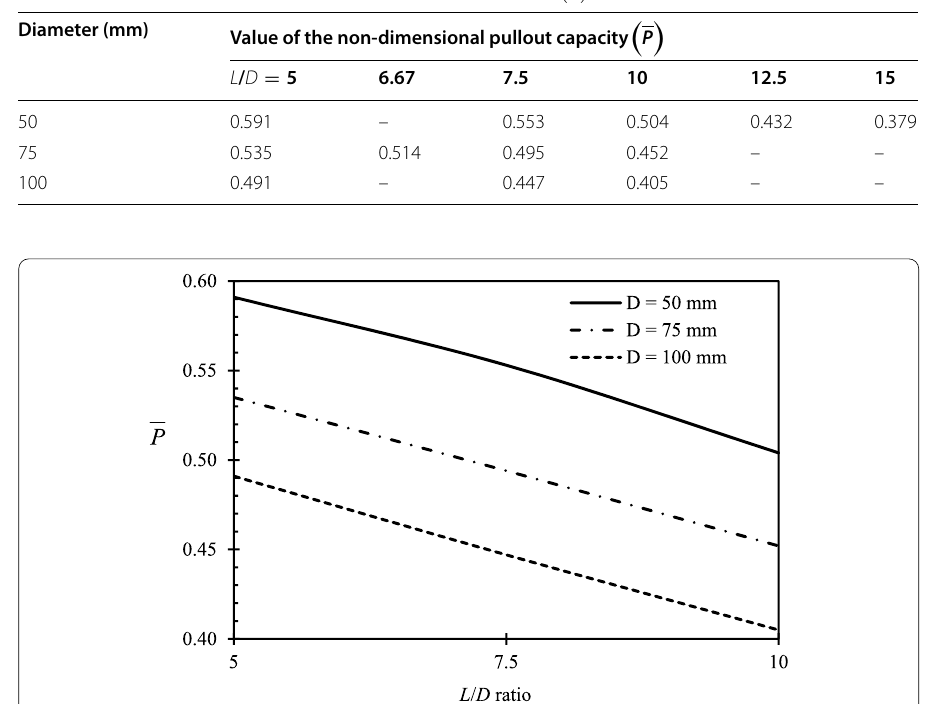
Fig. 14 Variation in non-dimensional pullout capacity with L / D